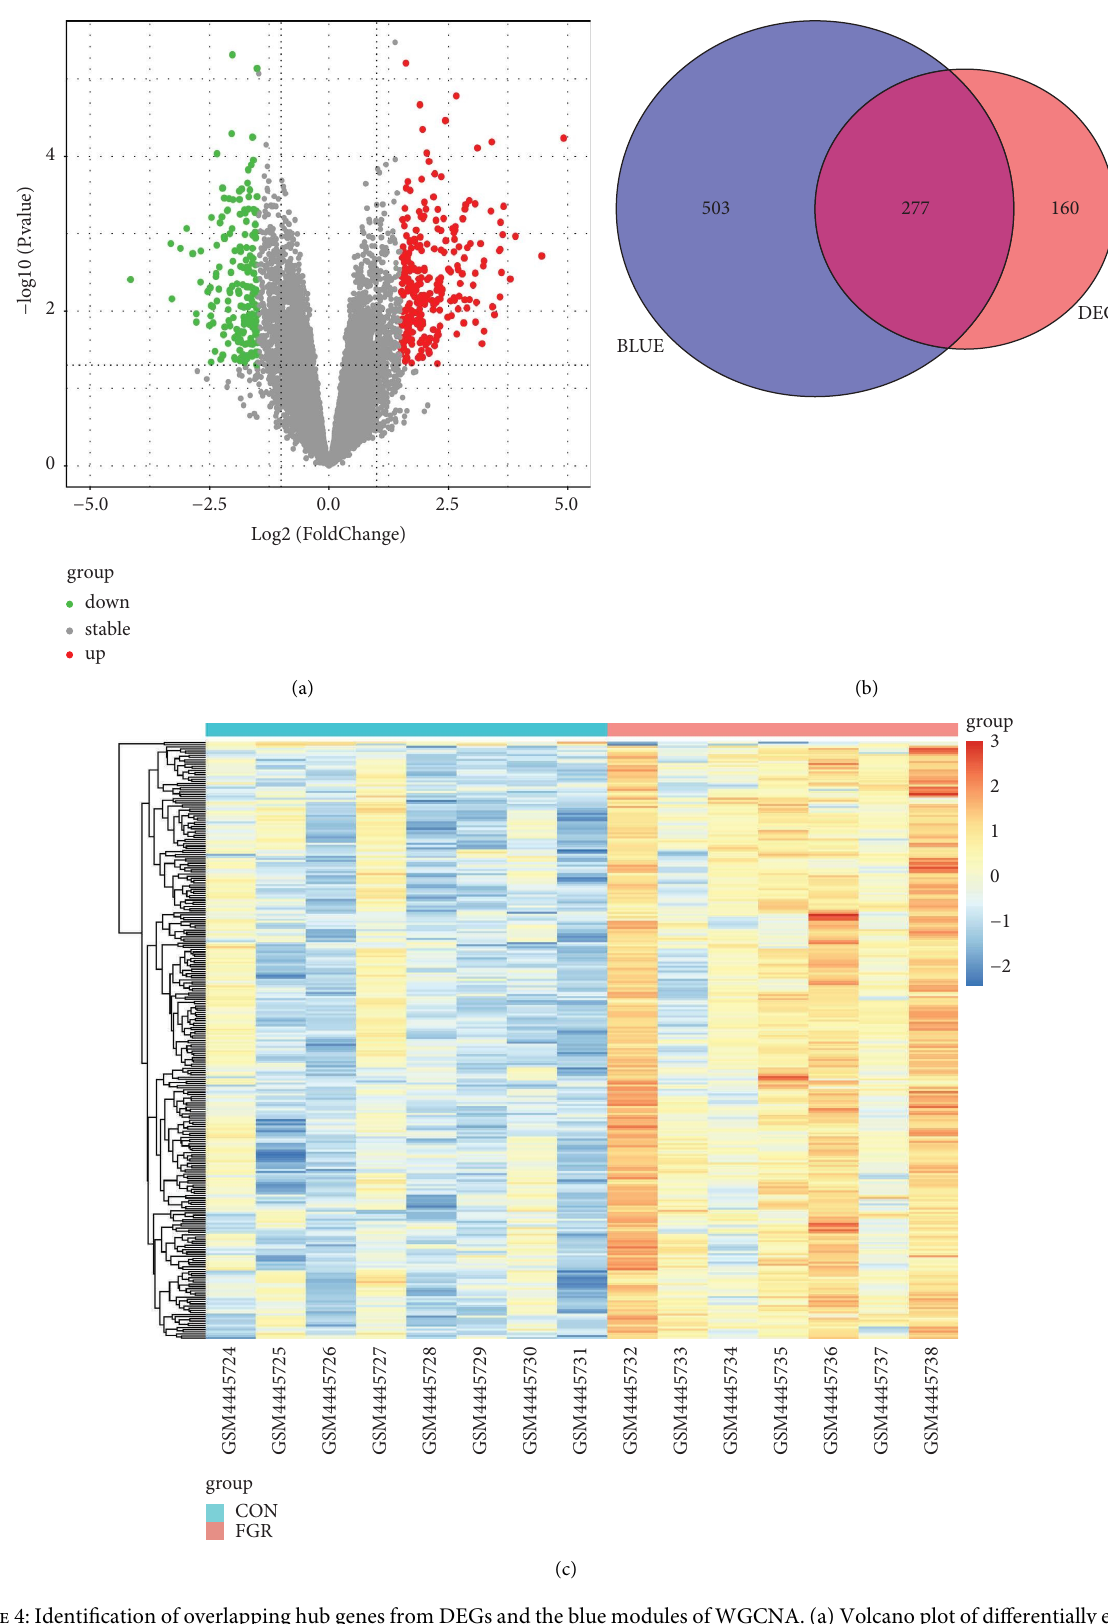
Figure 4: Identifcation of overlapping hub genes from DEGs and the blue modules of WGCNA. (a) Volcano plot of diferentially expressed genes (DEGs) from GSE147776 normal and FGR samples. (b) Venn diagram representing overlapping genes in diferentially expressed genes (DEGs) and the blue module of WGCNA. (c) Heatmap of overlapping hub